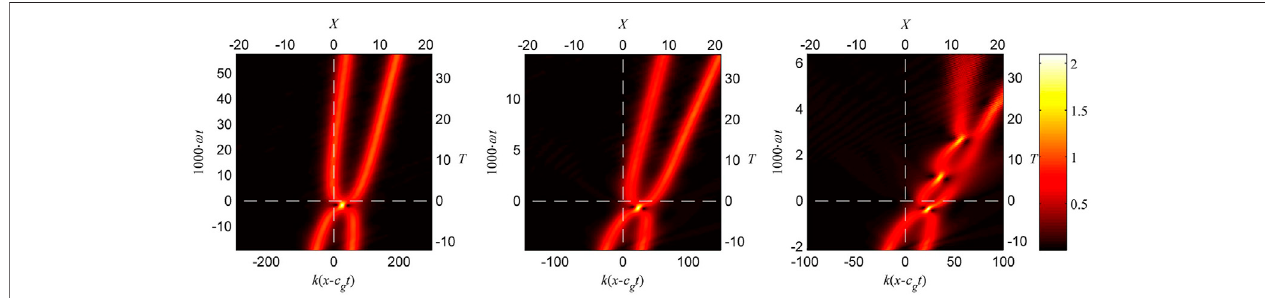
FIGURE6| Numericalsimulations oftheEulerequationsofthedegenerate soliton fordifferentsteepnessvaluesoftheinitialcondition: ka (cid:2) 0.05 onthe leftpanel , ka (cid:2) 0.1 on the middle panel , and ka (cid:2) 0.15 on the right panel . The color-coded evolution of the wave envelope Ψ env is shown.